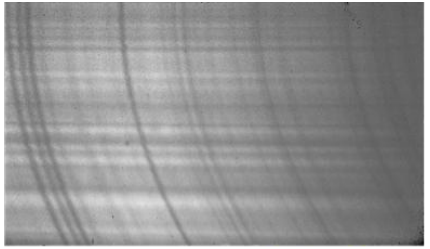
Figure 6. Spectral image used in radiometric calibration spectral dimension is horizontal, while the spatial dimension of the split is along the vertical